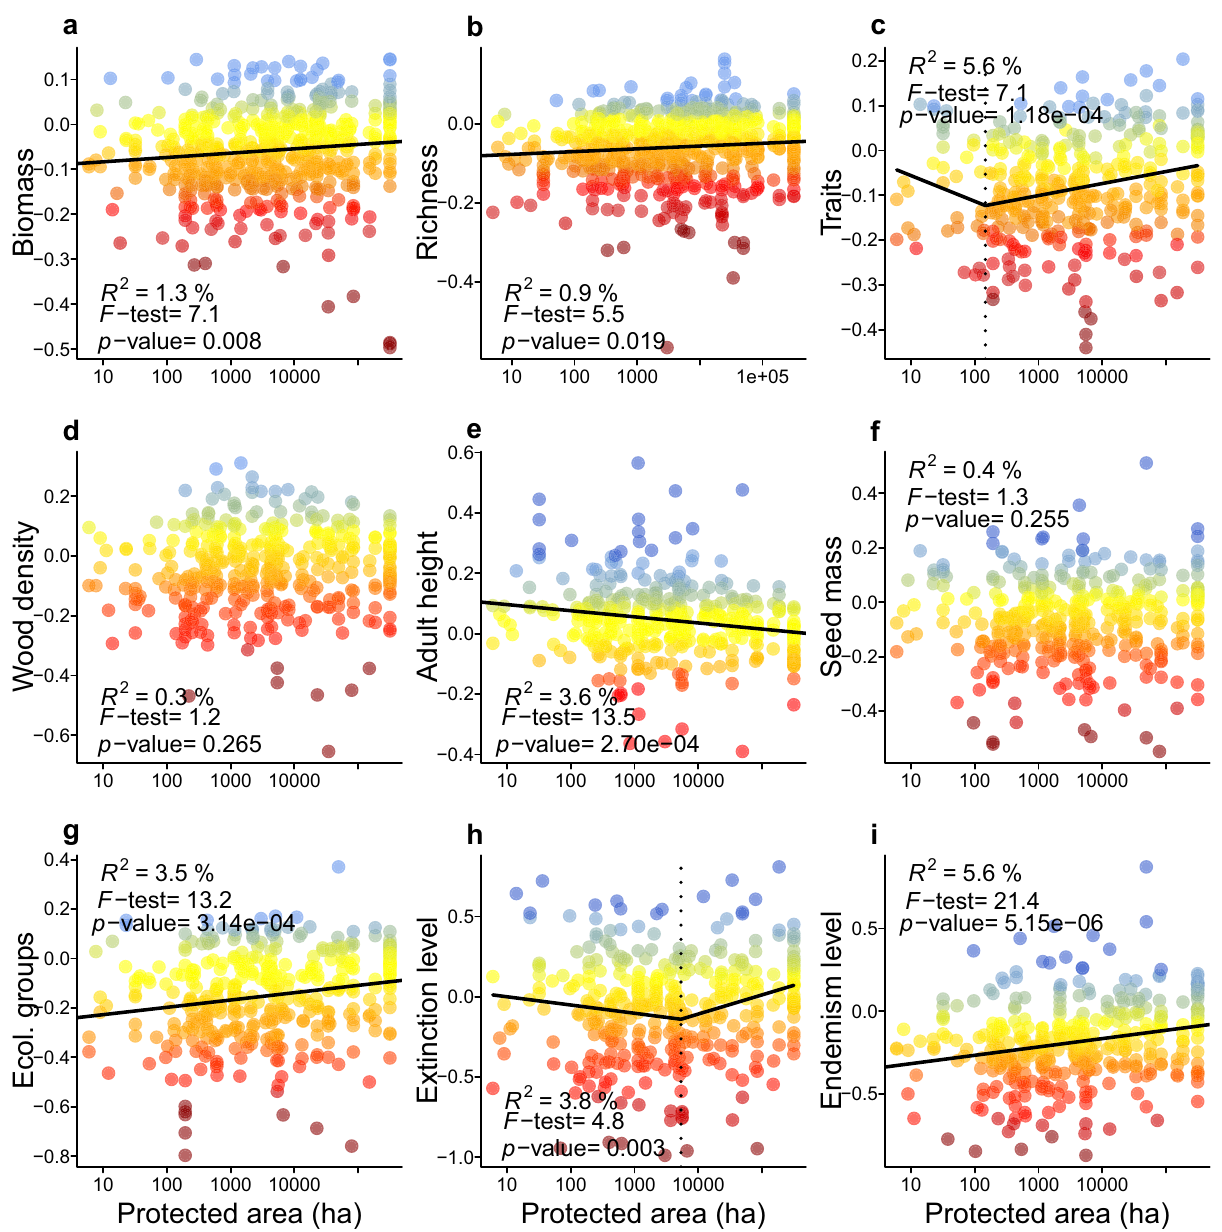
Fig. 5 The effect of the size of the protected area on the loss of forest biomass, species richness, and species properties. For each survey (points), panels present the indices of loss of a forest biomass ( n = 555 surveys); b tree species richness ( n = 617 surveys); c weighted average species property loss; d wood density; e maximum height; f seed mass; g ecological groups; h threat of extinction; and i endemism level. The summary of the linear or of the piecewise regression models is given in the top of each panel, along with the adjusted R 2 of the model, its summary F -statistics and the associated p -value (one-sided statistical test). Degrees of freedom for the regression models are: panel a = 554, panel b = 616, panels c – h = 364. The vertical dashed line is the estimated break-point of the piecewise model, which is plotted only for the variables were this model had a better performance than the linear model. The standardized index of loss is dimensionless and is highlighted by different colours ranging from dark red (high losses) to blue